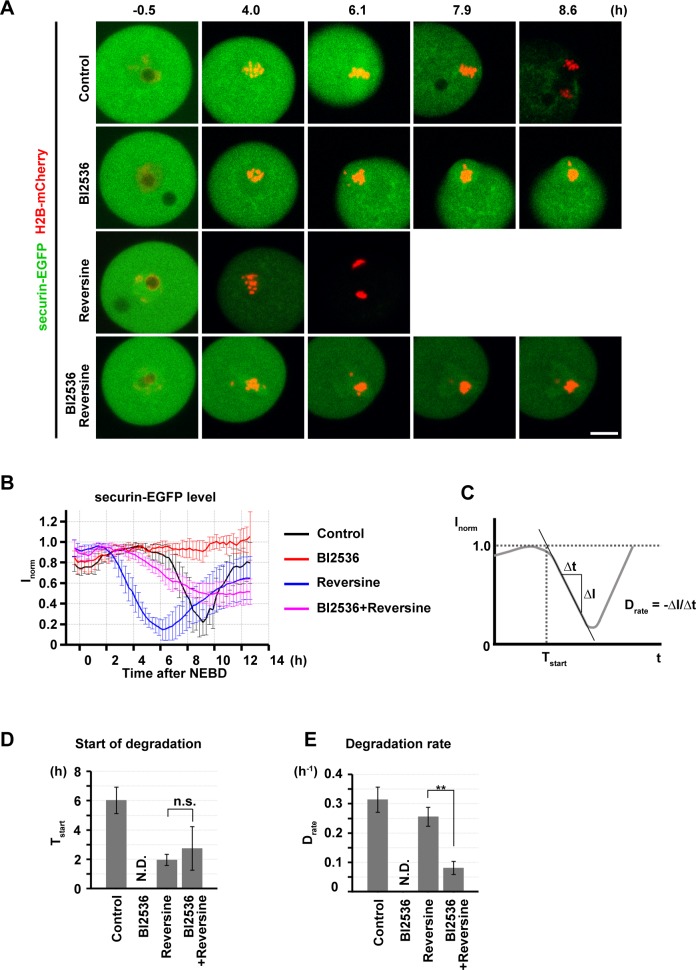
PLK1 activates the APC/C through multiple pathways.(A) Imaging of oocytes expressing securin-EGFP (green) and H2B-mCherry (chromosomes, red) in the presence of DMSO (control), 100 nM BI2536 and/or 1 μM reversine. Maximum intensity z-projection images are shown. Time after NEBD (h). Scale bar = 10 μm. Also see S5 Movie. (B) Normalized intensities of cytoplasmic securin-EGFP signals (Inorm) were plotted. Average and s.d. are shown (n = 6, 4, 12, 15). (C-E) A line was fitted to the decrease of Inorm (C). Time for the start of securin-EGFP degradation (Tstart) was defined as the time when the fitted line reaches the Inorm value 1.0. The degradation rate (Drate) was defined as the negative value of the slope of the fitted line. Averages with s.d. of Tstart and Drate are shown in (D) and (E), respectively (n = 6, 12, 15. **p < 0.01).